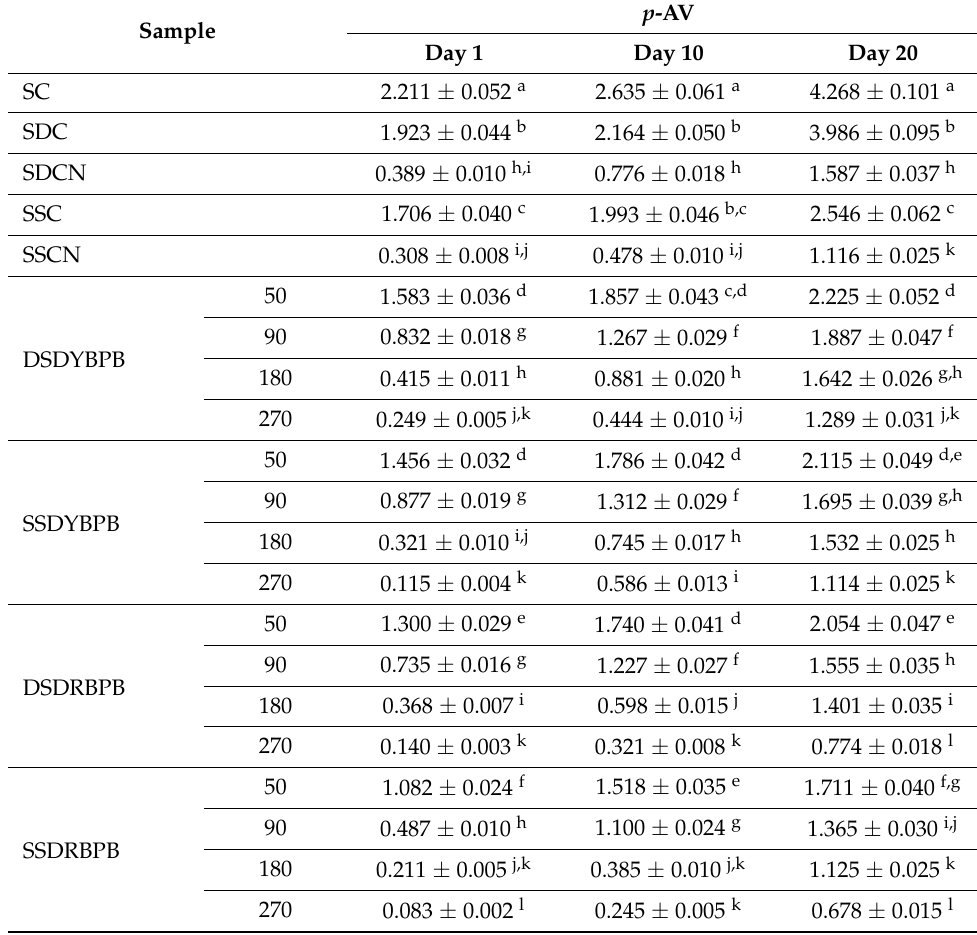
Table 5. The effect of supplementing sausage formulas with bell pepper processing by-products on p -anisidine value ( p -AV) during 20 days of